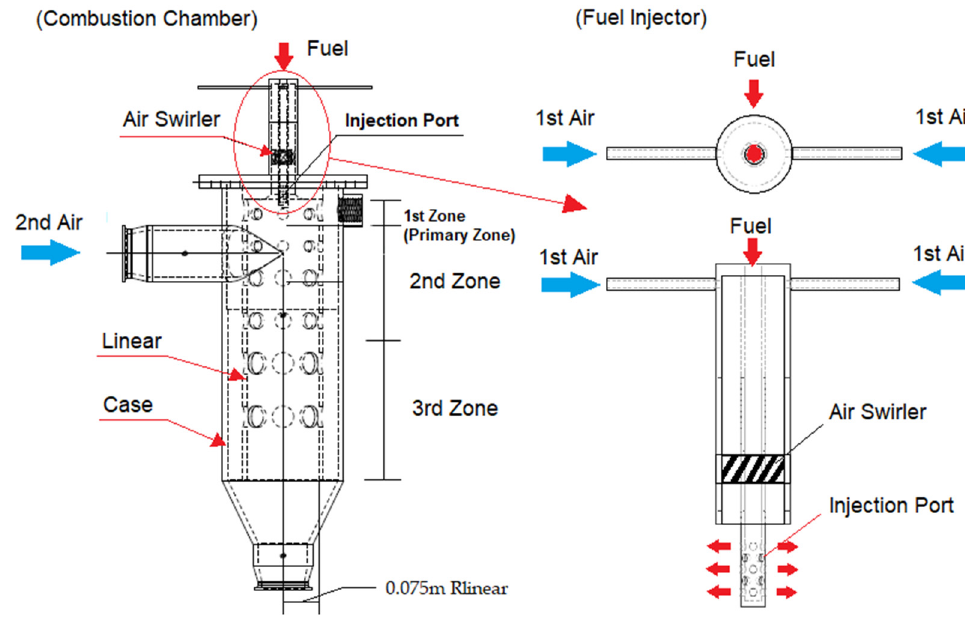
Figure 2. A cutaway view of the combustion chamber of the model MGT engine with the fuel injec- tor.